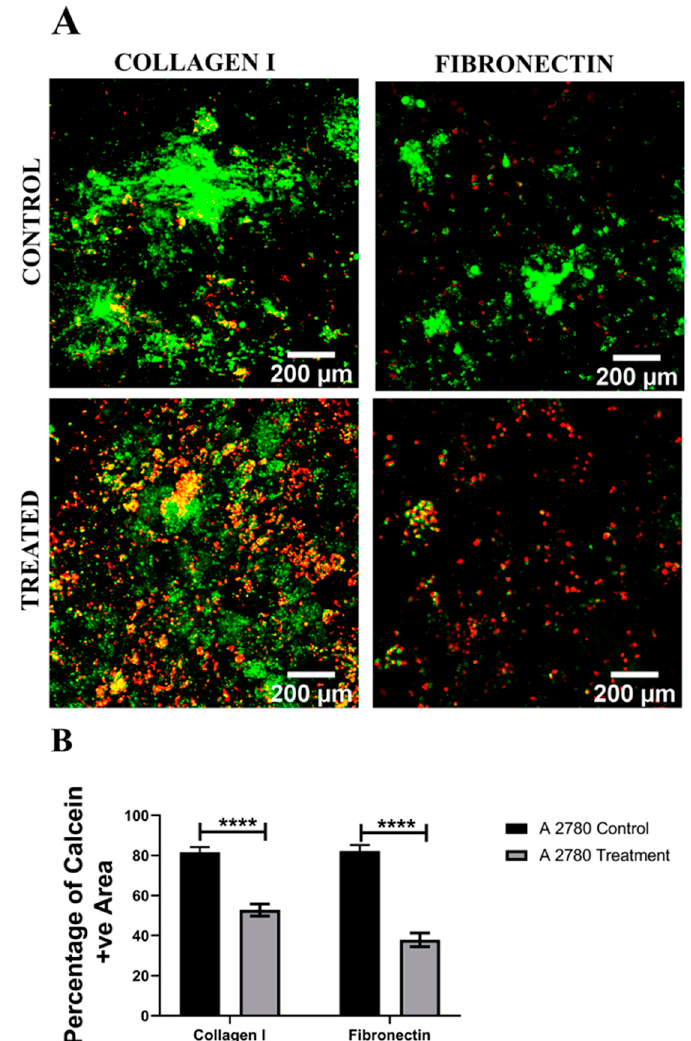
Figure 7 . Effect of the chemotherapeutic Cisplatin on the viability of A2780 EOC cells grown in PU scaffolds of various protein coatings, 24 h post-treatment ( A ): Representative images for live–dead (green–red) staining in collagen I- and fibronectin-coated treated and untreated (control) A2780 polymeric scaffolds. ( B ) Image analysis-based quantification of live (green) image areas for A2780 cells grown in collagen I and fibronectin coated polymeric scaffolds. Scale bar = 200 μ m. Quantitative data represent mean ± SEM for multiple images ( ≥ 3) and multiple scaffolds ( ≥ 3). **** p ≤ 0.0001 .